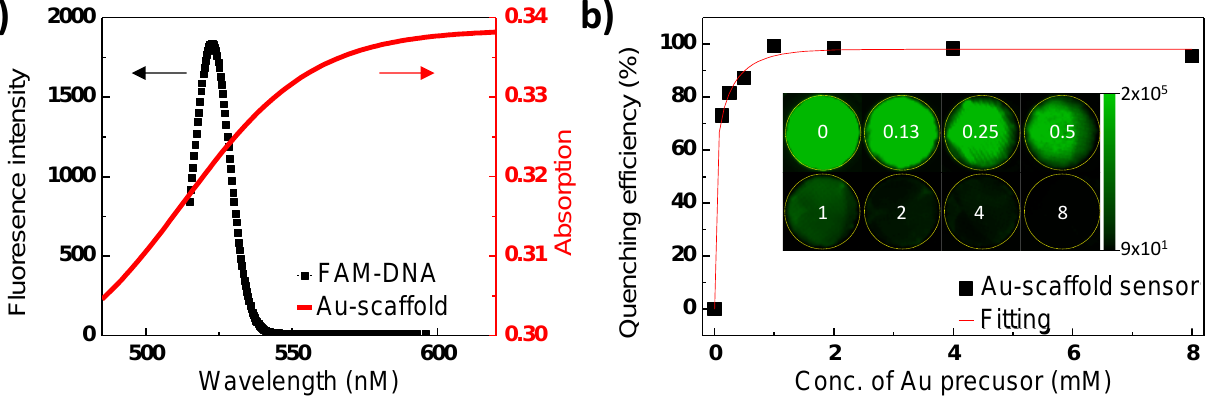
Figure 2. Optical properties of the Au-scaffold sensor. ( a ) The absorption of Au-scaffold (red line) and the fluorescence spectrum of FAM-labeled probe DNA (FAM-DNA). ( b ) FRET quenching efficiency of Au-scaffold.